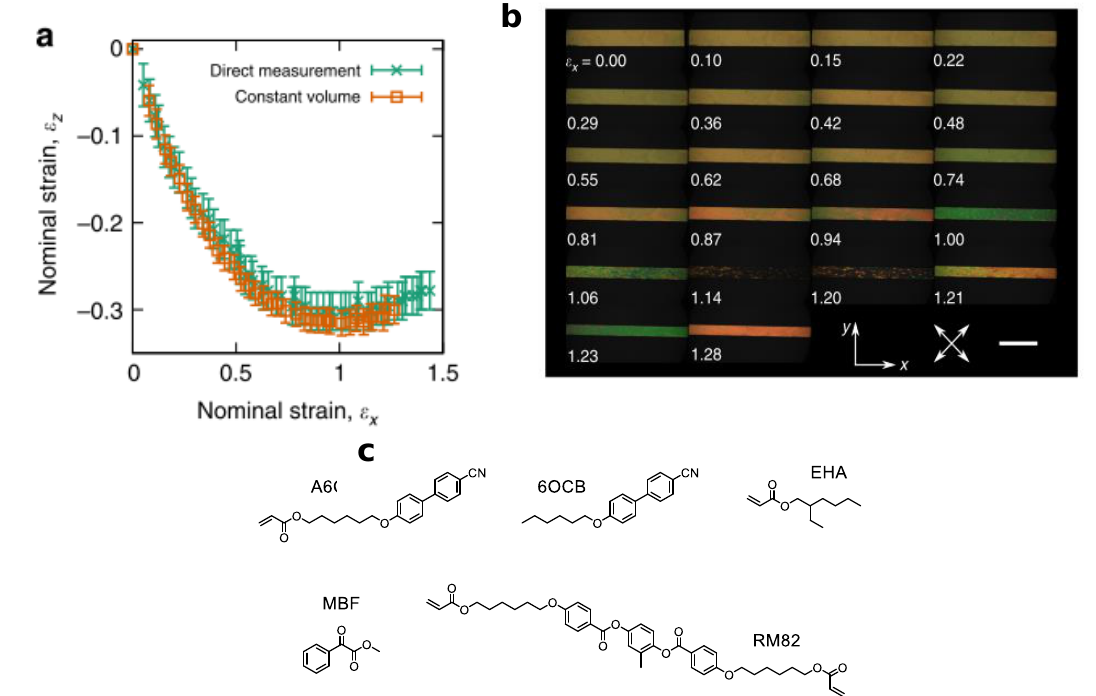
Figure 7. ( a ) z-axis strain, ε z in response to imposed x-axis strain, ε x , measured via direct observation of the polyacrylate-based auxetic LCE in the xz plane (green crosses) and through the application of the constant volume condition to strain measurements of the xy plane (orange boxes). Errors are measurement errors ( n = 1). ( b ) Negative order from polarising microscopy. Polarising microscopy textures at different strains. The birefringence colours indicate the retardance initially decreases, becoming zero at ε x = 1.14, before increasing again. Scale bar, 5 mm. ( c ) shows the constituents used to synthesise the auxetic LCEs reproduced with permission from Nature from Mistry et al. [2].